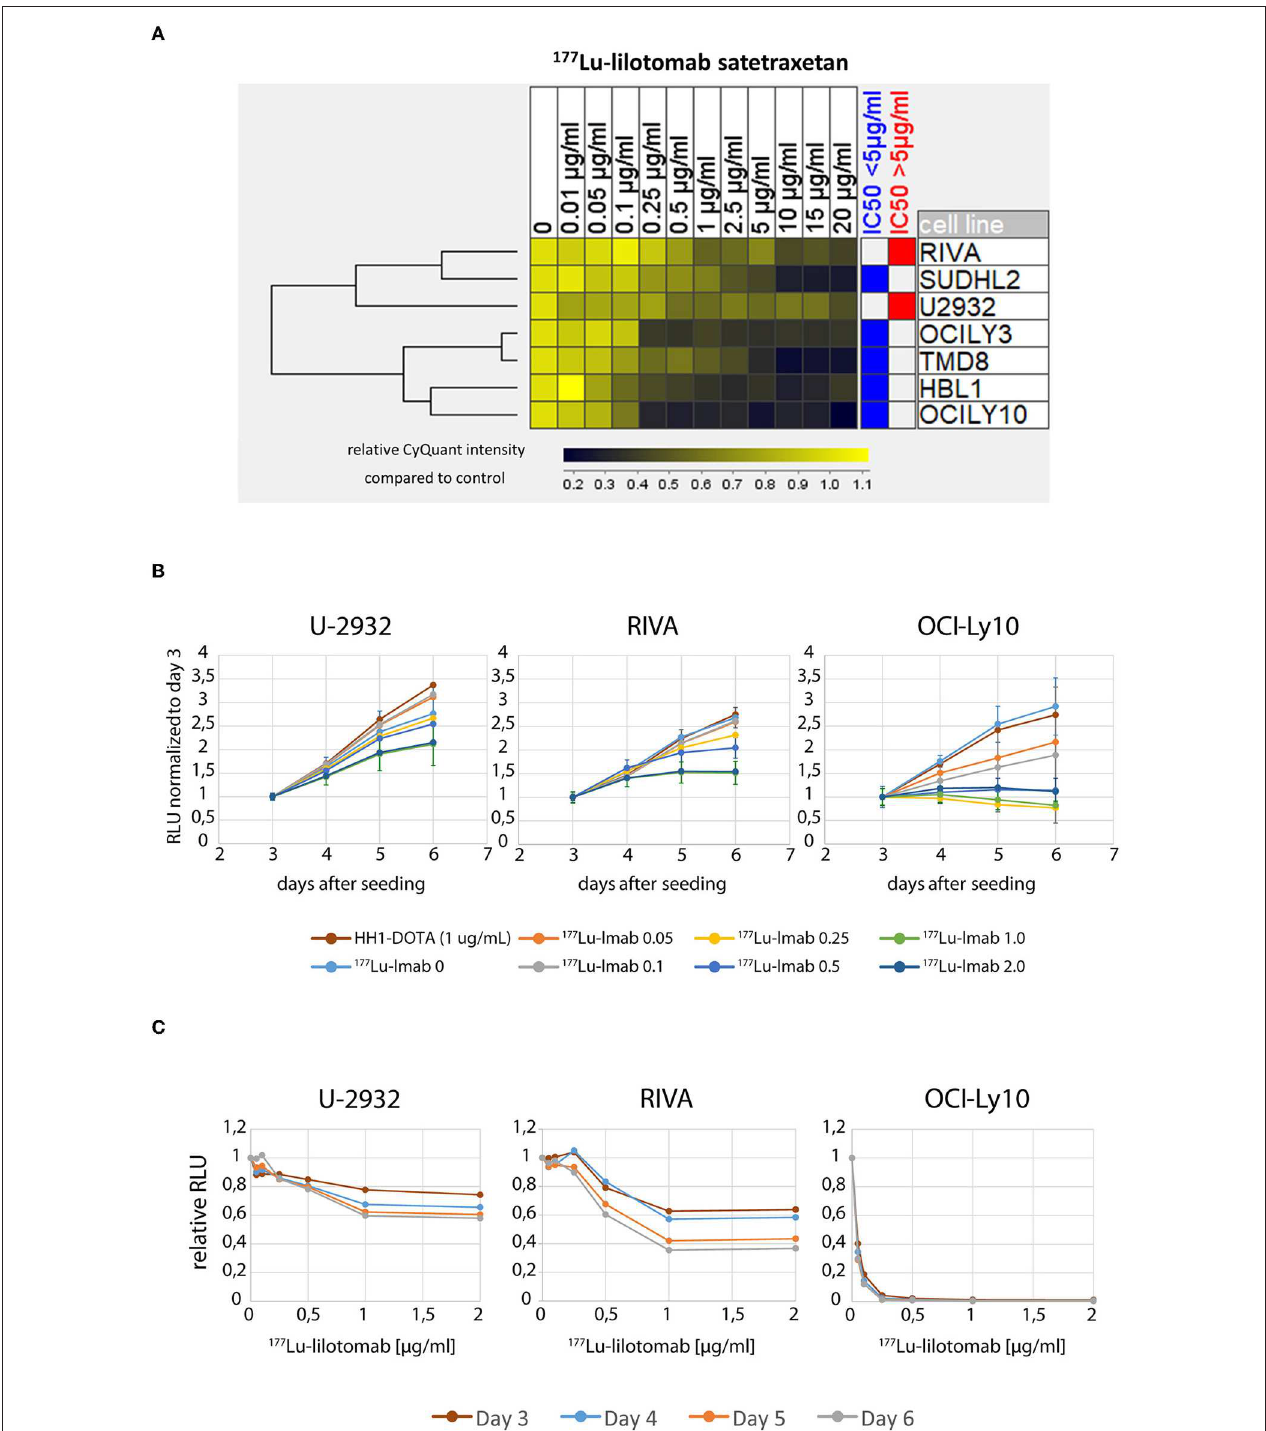
FIGURE 1 | U-2932 and RIVA are resistant to CD37-targeted 177 Lu-radioimmunotherapy. (A) Cells were treated for 18h with 11 different doses of 177 Lu-lilotomab satetraxetan ranging from 0.01 to 20 µ g/mL (specific activity: 600 MBq/mg), washed and plated in 96-well plates. Mock treated cells were included as control. The total DNA content in each well was assessed using the CyQuant reagent as an equivalent of cell proliferation. (B,C) Treated as in (A) with doses of 177 Lu-lilotomab satetraxetan ranging from 0 to 2 µ g/mL or cold antibody (HH-1-Dota) and measuring proliferation utilizing MT, RealTime-Glo, adding luminescent assay substrate 72h after seeding in micro-well titer plates. (C) Relative RLU ( 177 Lu-lilotomab satetraxetan to control) of data presented in (B) . Error bars: Standard deviation (STDEV) ( n = 5 for U-2932 and RIVA, n = 3 OCI-Ly10). Inhibition of cell proliferation on days 5 and 6 were significantly reduced compared to control ( p < 0.001, 1-way ANOVA) in U-2932 cells at doses ≥ 1 µ g/mL, in RIVA at doses ≥ 0.25 µ g/mL, and Oci-Ly10 at doses ≥ 0.1 µ g/mL.